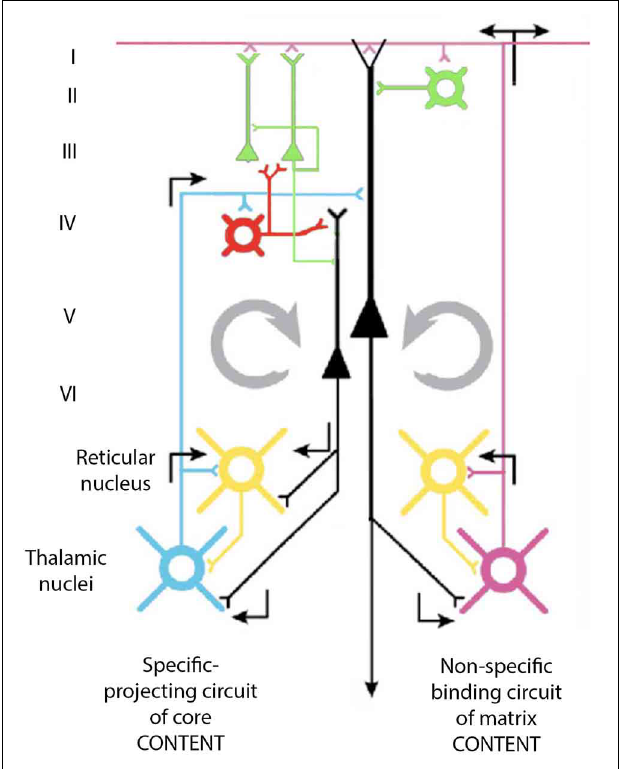
FIGURE 14 | Diagram of the proposed cortico-thalamo-cortical reverberating circuit, which may underlie 40-Hz oscillation at the cortex. See